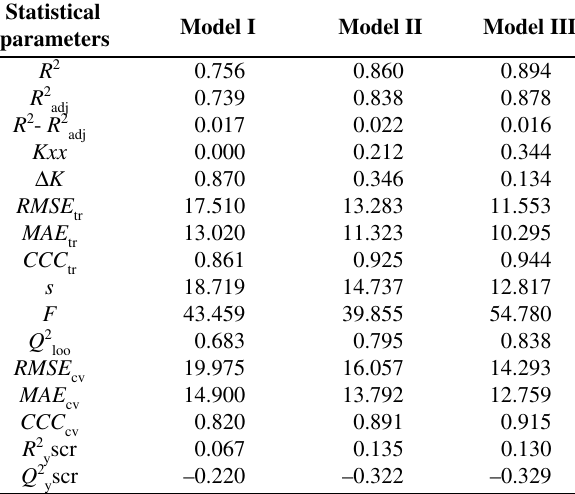
Table 2. Statistical parameters of the obtained QSAR models.